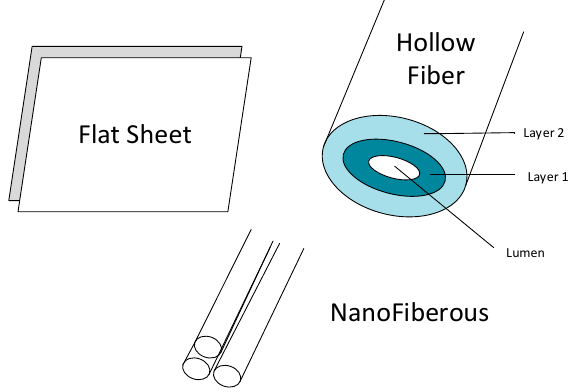
Figure 21. Shapes of natural composite membranes: ( a ) flat sheet, ( b ) hollow fiber, and ( c ) nanofibrous. The manufacture of polymer membrane depends on the type of polymer and the required film structure: phase inversion, interfacial polymerization, stretching, etching, and electrospinning. Phase inversion: a homogeneous polymer solution changes from a liquid to a solid in a controlled manner [254], by immersing it in a non-solvent, that is, water.